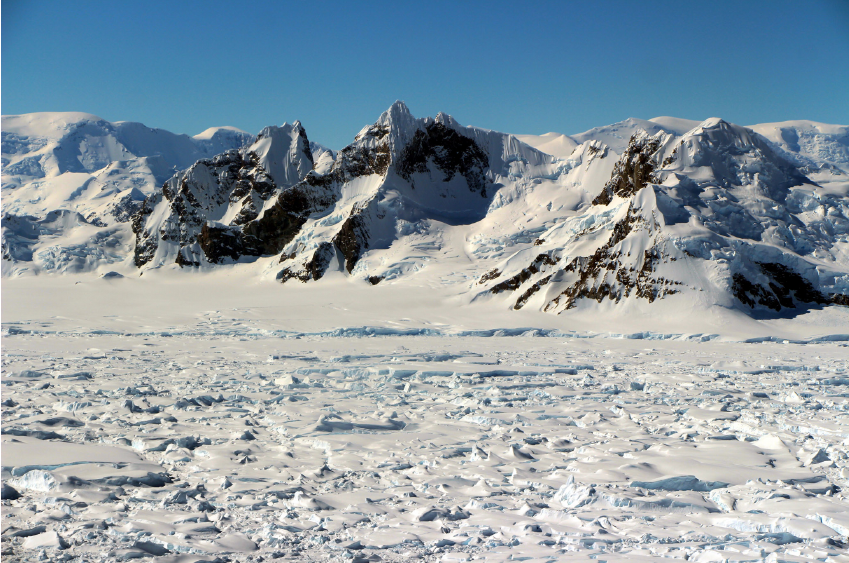
Figure 2. Photograph of Wordie Bay on 21 November 2017 taken at 69.230 ◦ S and 68.430 ◦ W. The broken-up remains of the Wordie Ice Shelf are in the foreground. Photo credit: John